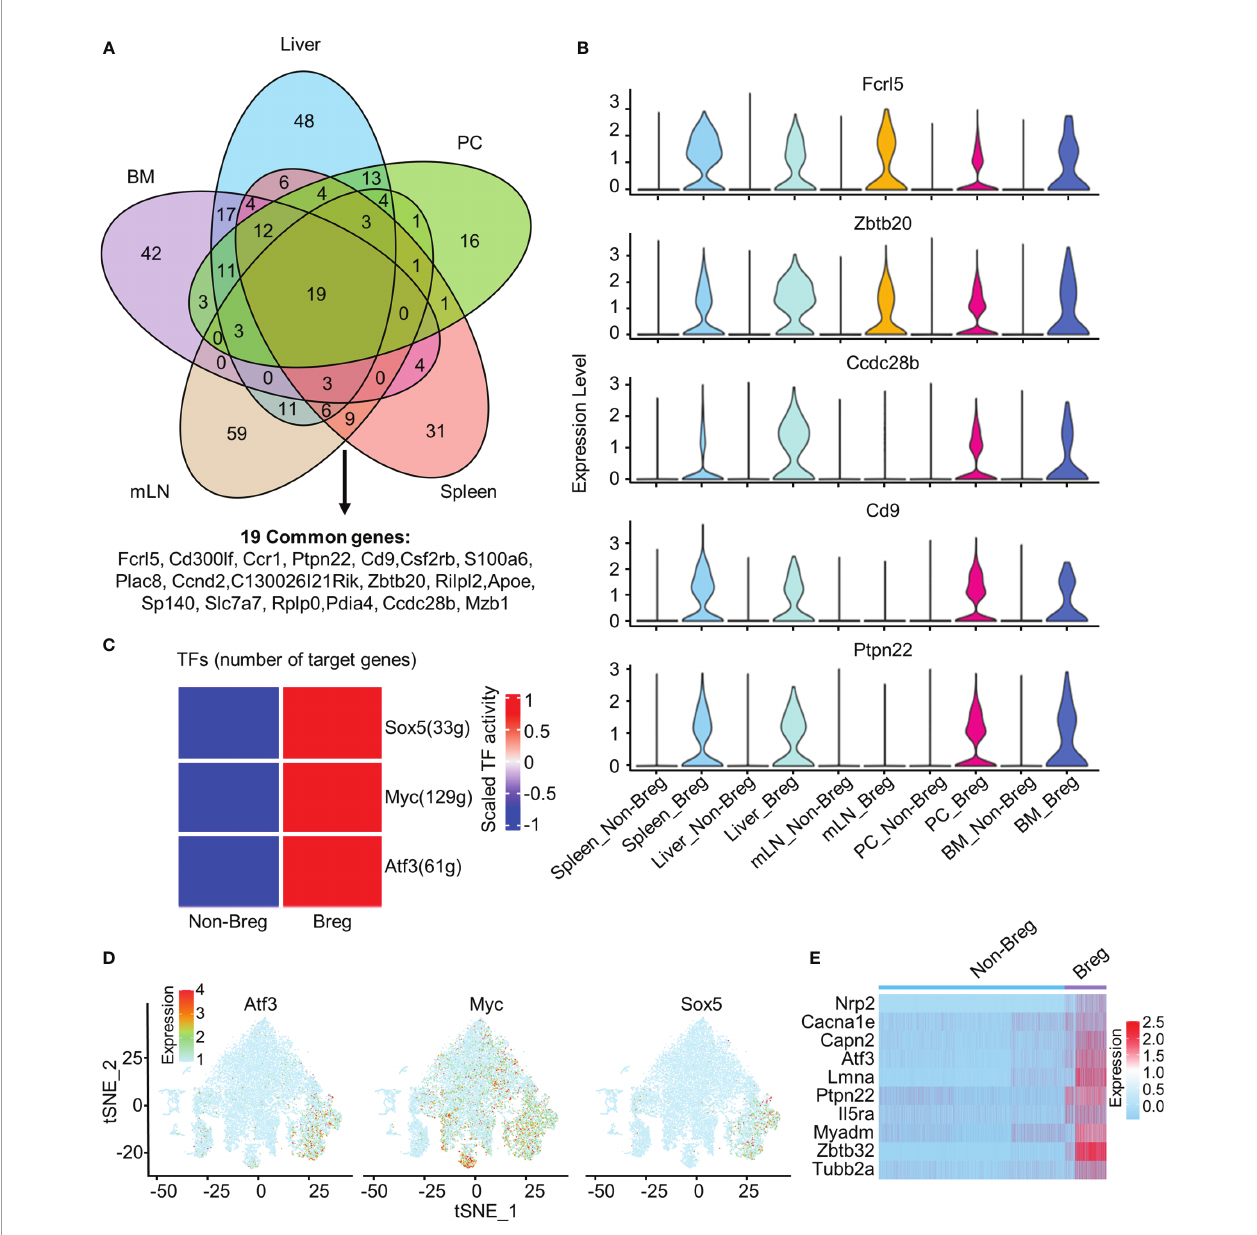
FIGURE 2 | Common marker genes and transcription factors in Breg cells. (A) Venn diagram showed the overlap of upregulated DEGs by comparing Breg cells with non-Breg cells in different organs. (B) Violin plots represented the normalized expression of Fcrl5 , Zbtb20 , Ccdc28b , Cd9 , and Ptpn22 in Breg cells and non- Breg cells across different organs. (C) Heat map of the activation scores of 500 randomly selected Breg cells and 500 non-Breg cells from all organs for expression regulated by transcription factors (TFs). (D) Feature plot of Atf3 , Myc , and Sox5 expression of three TFs on total B cells from all organs. (E) Heat map of Atf3 -related gene expression between Breg cells and non-Breg cells in total B cells from all